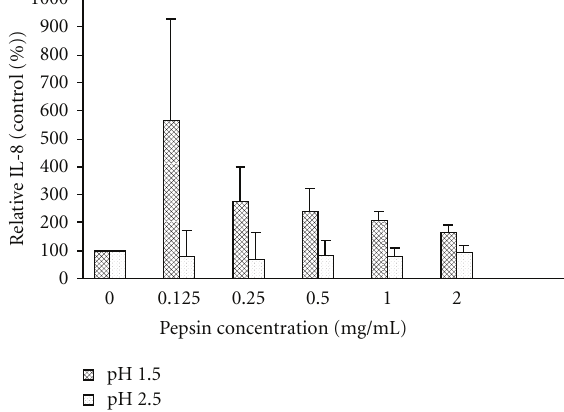
Figure 5: Interleukin-8 production by 16-HBE cells, corrected for cell proliferation and expressed as a % of exposure with the corresponding pH without pepsin (control). Interleukin-8 release induced by pepsin is higher at pH 1.5 compared to pH 2.5 (mean di ff erence 221%; P < 0 . 01). Data expressed as mean (histograms) and SEM (bars) for 3 replicates. See supplement Figure 3 for induction of IL-8 at all pepsin concentrations and pH levels used in the statistical